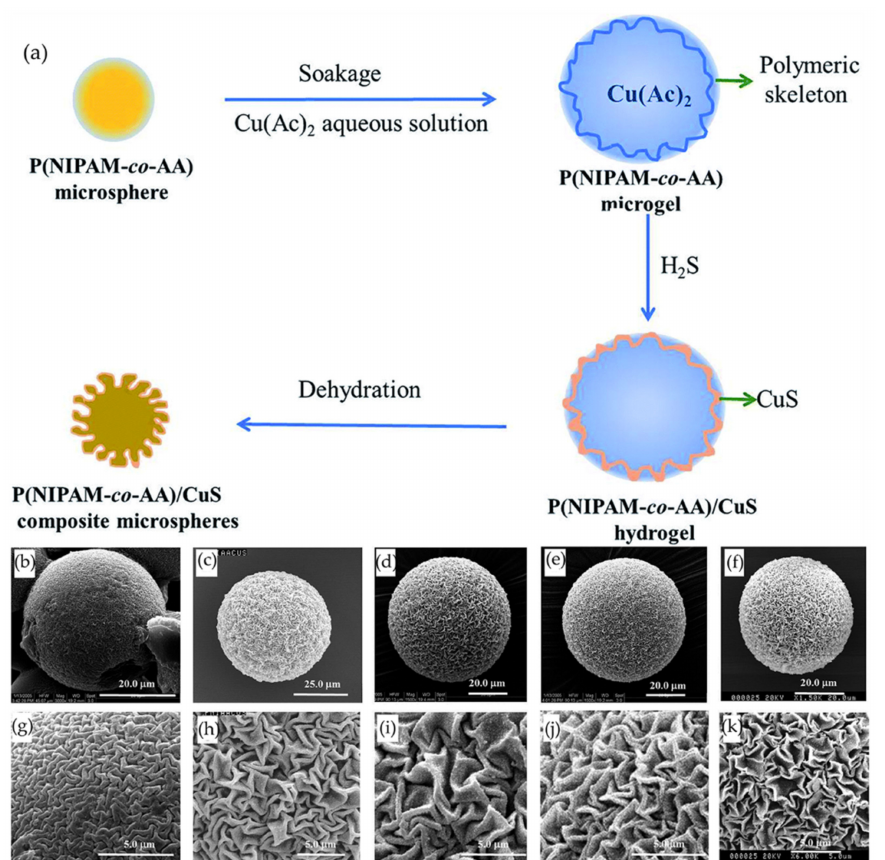
Figure 12. ( a ) Preparation of (P(NIPAM- co -AA)/CuS) microspheres, SEM micrographs P(NIPAM- co -AA)/CuS by adding HAc (pH = 3) ( b , g ), H 3 BO 3 ( c , h ), ethylenediamine ( d , i ), pH = 5.6 ( e , j ) and pH = 9.2 buffer solution ( f , k ). Reproduced with permission from reference [59]. Copyright 2021, Royal Society of Chemistry